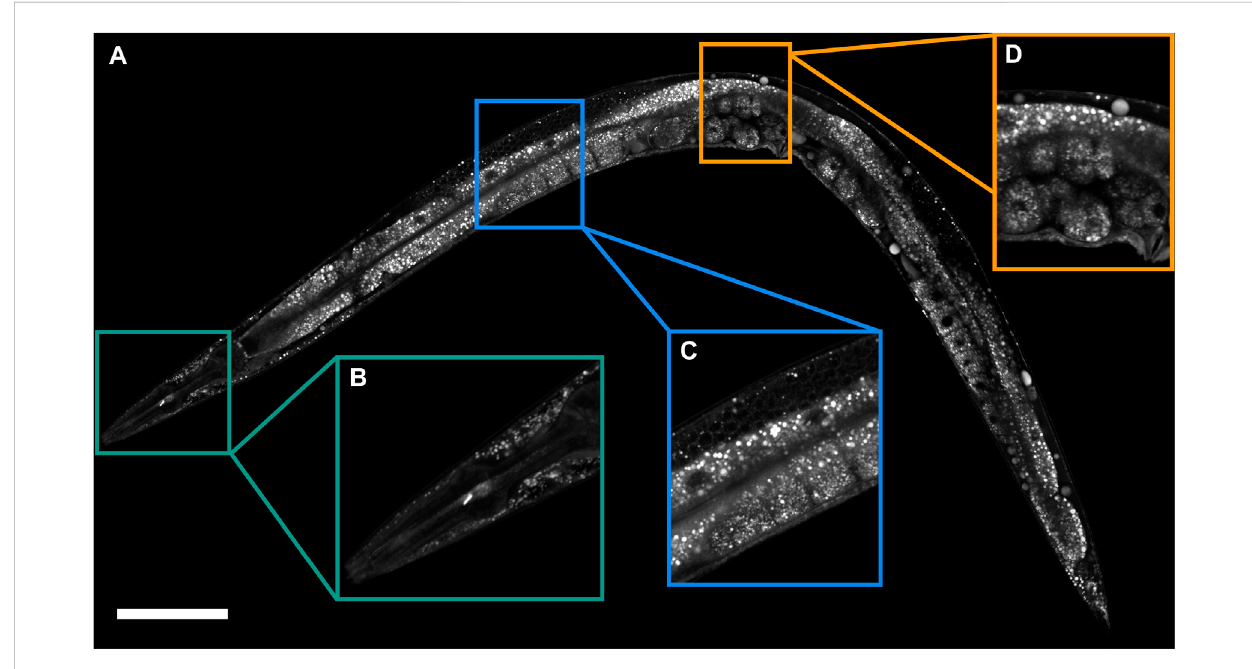
FIGURE 1 Lipid structuresrevealed byNile Red 2p-FLIM. (A) 2p-FLIM image ofaNile-Red-stained 1-day adult wild-type worm. (B – D) The expansionregion of the head, intestine/gonad, and embryos, respectively. Scale bar, 100 μ